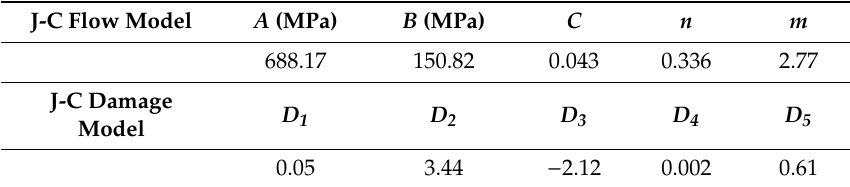
Table 3. Johnson-Cook’s flow and damage